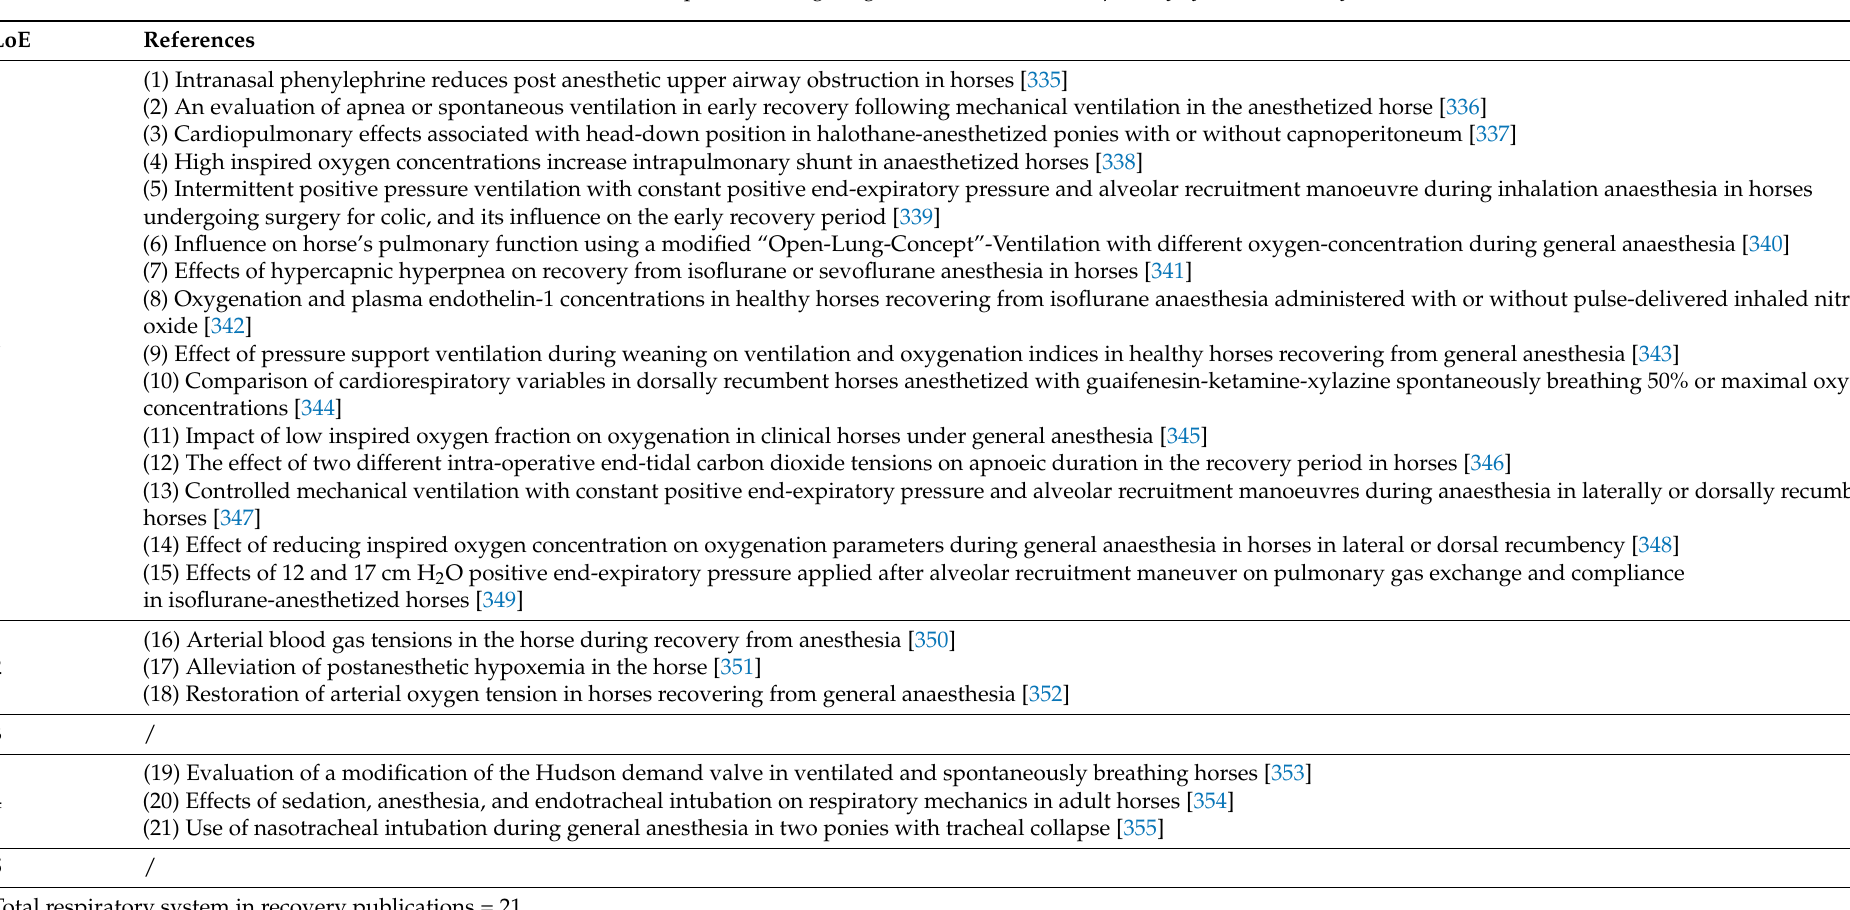
Table 10. Total of publications giving information about “ respiratory system in recovery